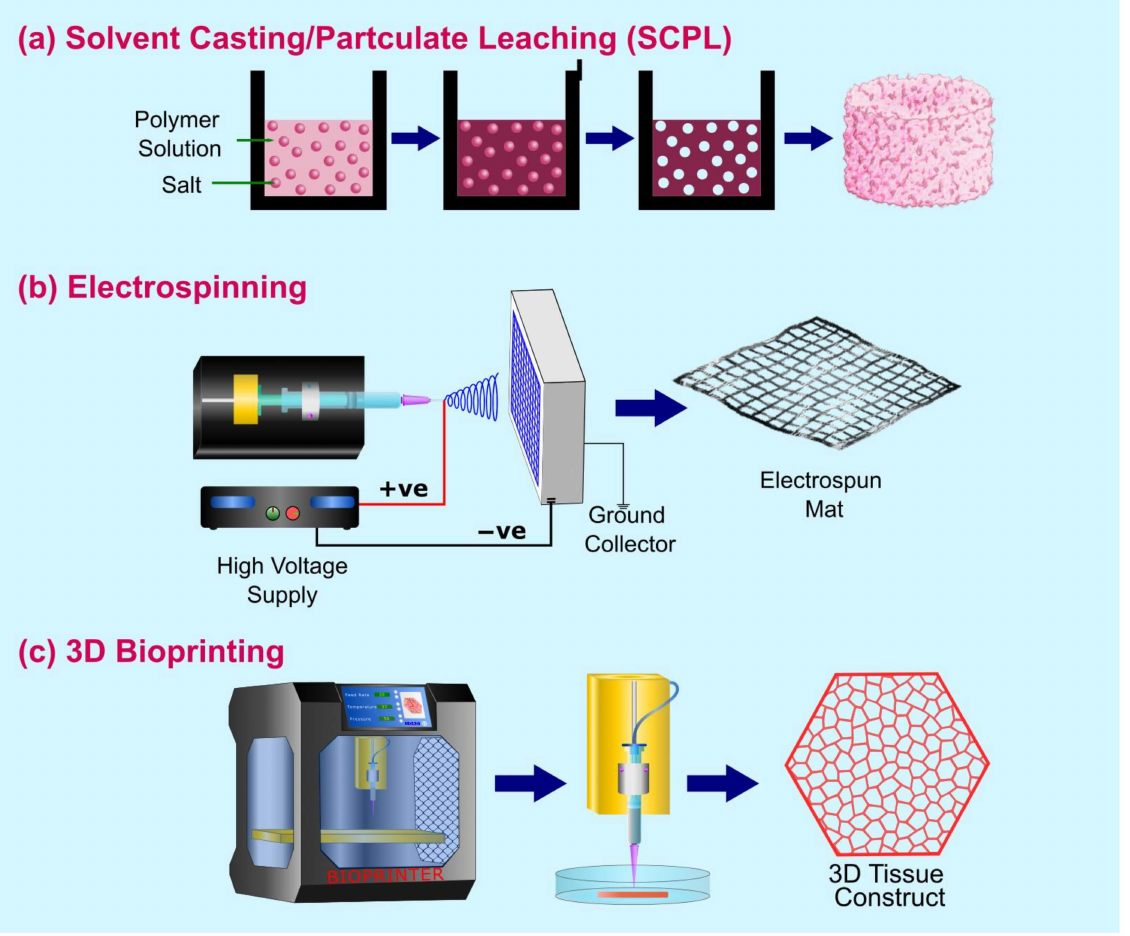
Figure 3. Schematic representation of the methods used in the generation of 3D tissue